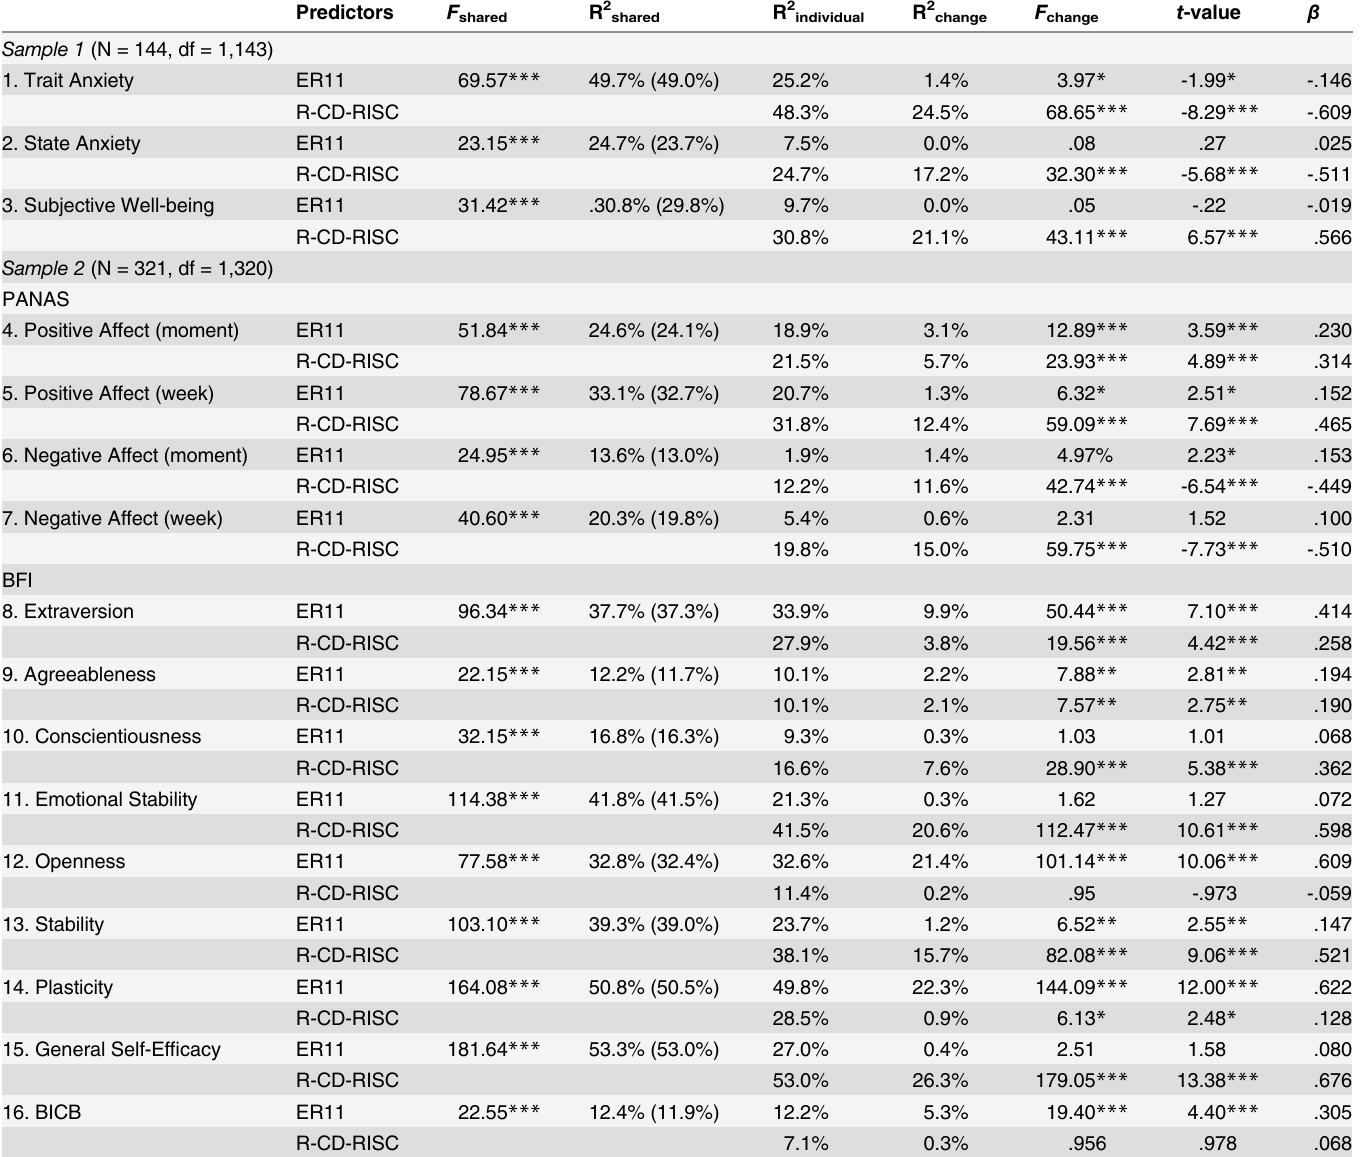
Table 7. Incremental validity testing of the ER11 through hierarchical multiple linear